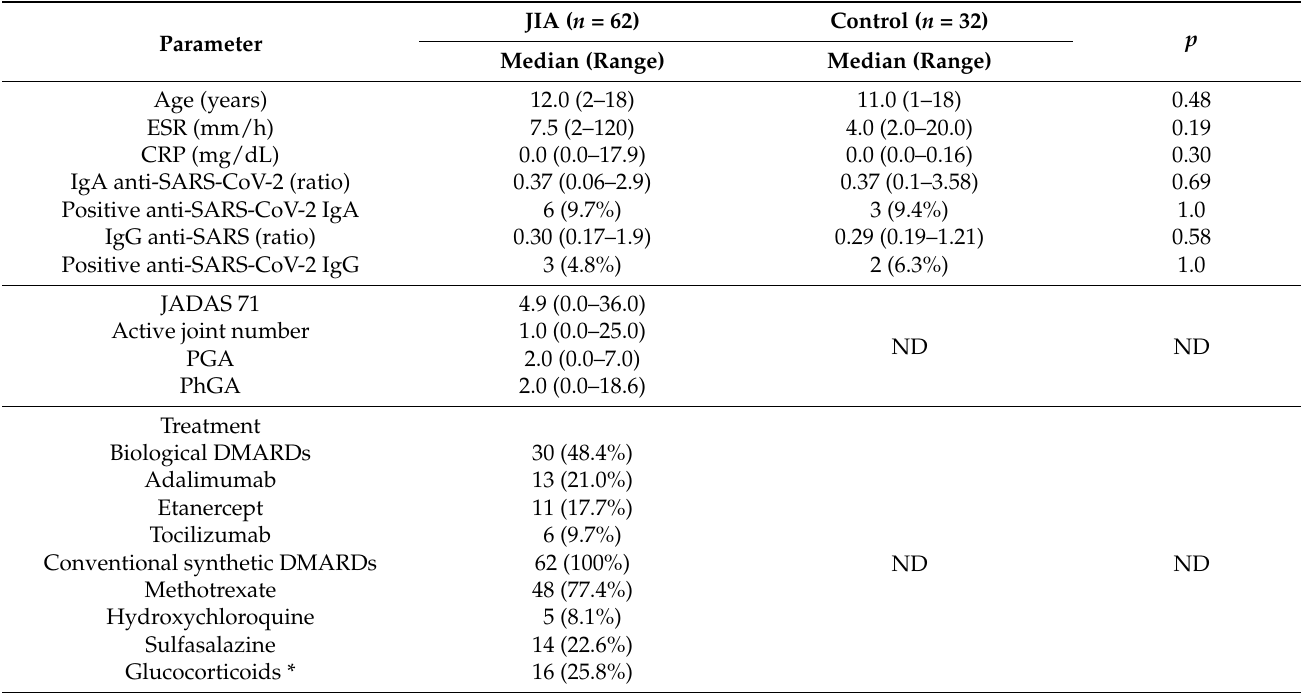
Table 1. Baseline demographic and clinical characteristics of the patients.